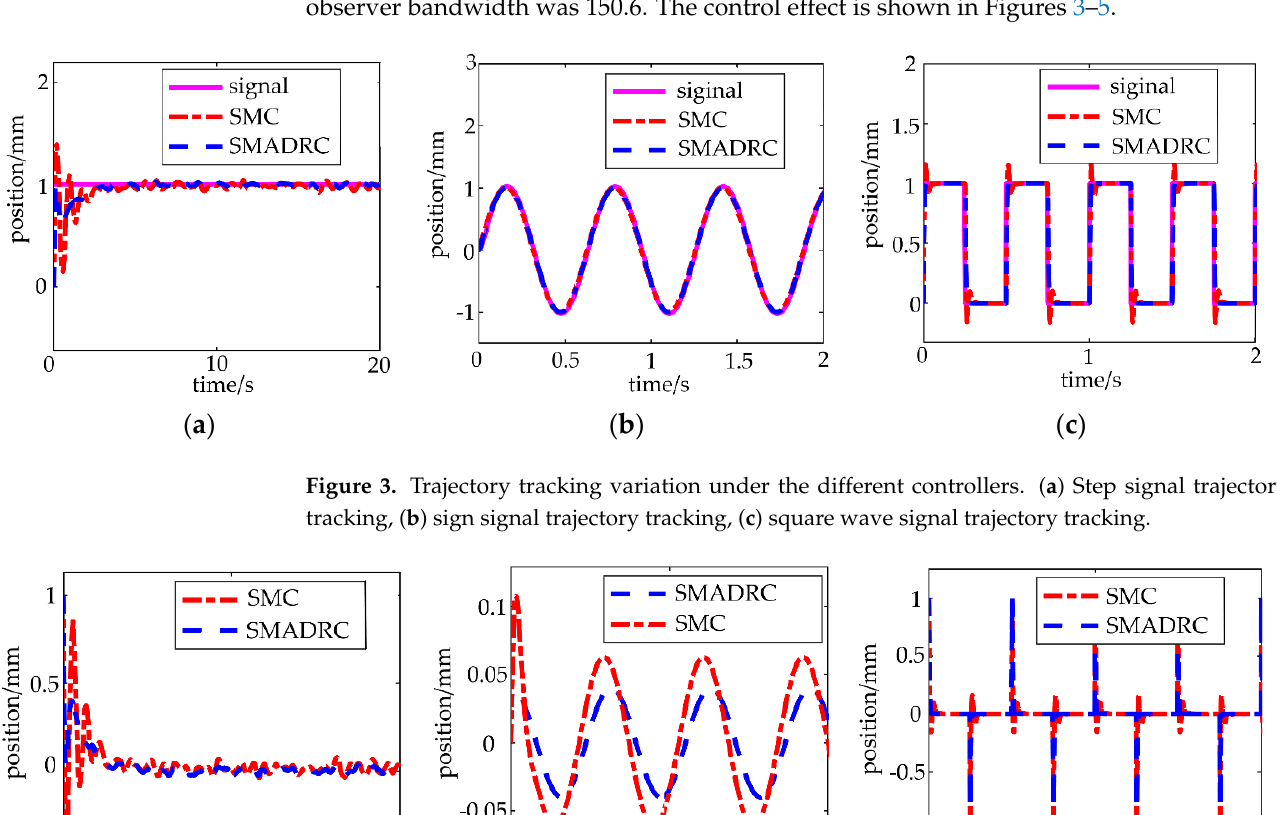
( c ) Figure 5. The perturbation estimation under the different tracking, ( a ) the perturbation estimation under the step signals, ( b ) the perturbation estimation under the sign signals, ( c ) the perturbation estimation under the square wave signals. In Figures 3–5, SMC means the sliding-mode control, and SMADRC means the pro- posed sliding-mode active disturbance rejection control. As shown in Figure 3, under the external disturbance, the SMC showed significant jitter in both the step trajectory and the square wave trajectory, while the SMADRC tracked well and had better robustness. Figure 4 shows the tracking error changes of the two control algorithms. It can be seen that the tracking error of the SMADRC was lower than SMC for all three tracking tasks, and SMADRC also entered the steady state more quickly. Especially in Figure (b), the tracking error changed greatly for SMC at the beginning of simulation. Figure 5 shows the estimated perturbation curves of SMADRC. The actual outputs of the active disturb- ance rejection observer were all close to the set values, which indicates the effectiveness